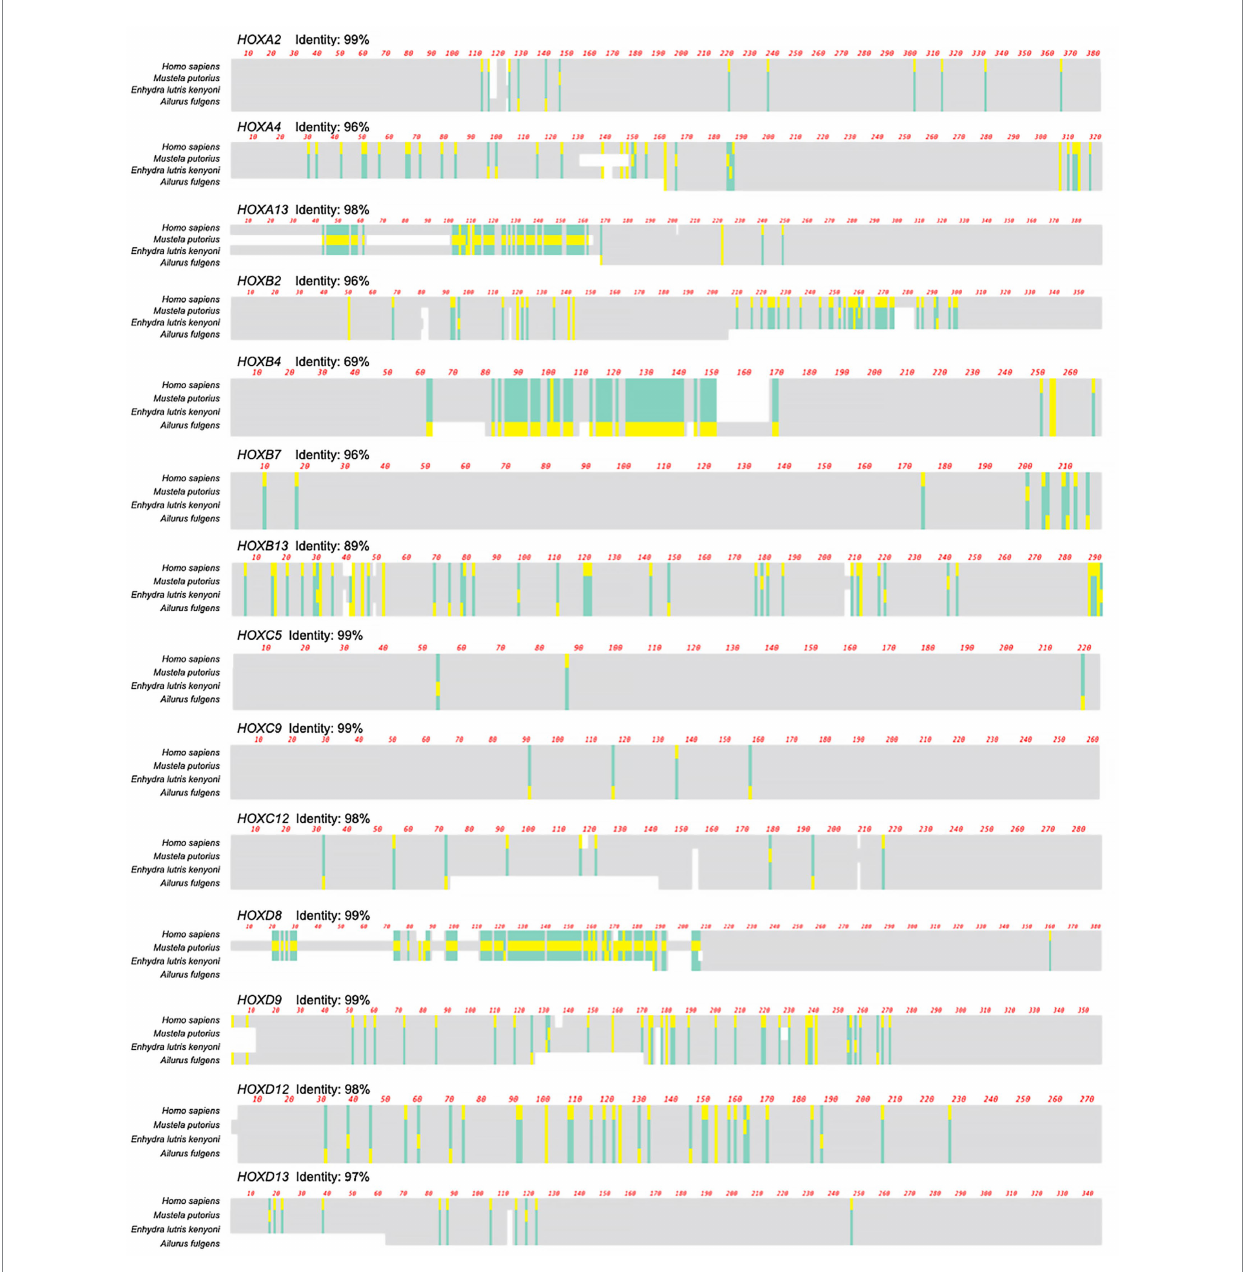
FIGURE 2 Multiple sequence alignment of 14 reannotated HOX genes in Ailurus fulgens . Three species ( Homo sapiens, Mustela putorius, and Enhydra lutris kenyoni ) were aligned to show the consistency of HOX gene reannotation. The sequence identity (%) between Homo sapiens and Ailurus fulgens is shown in each panel. The identical amino acid residues are shown in gray, in contrast to the different residues among species, which are colored green and